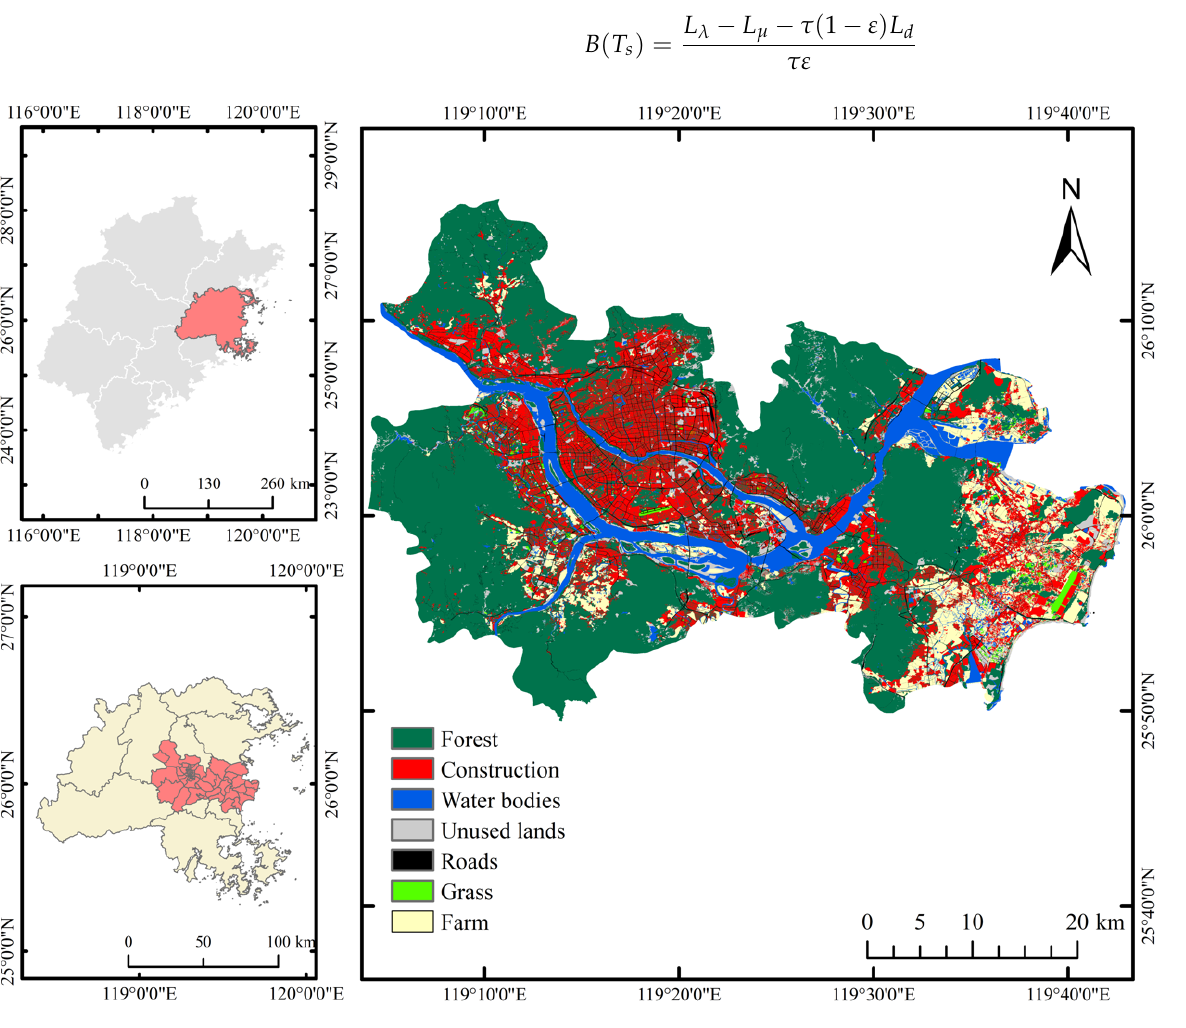
Figure 1. Study Area.